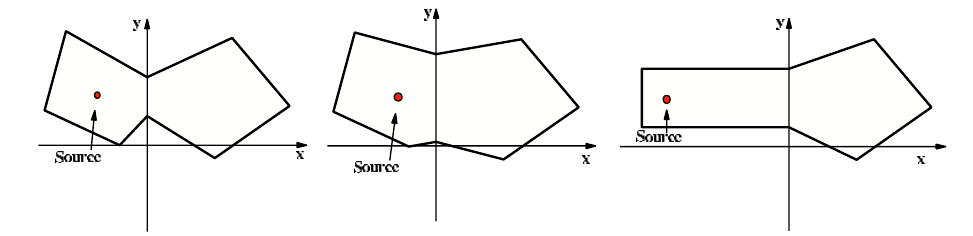
Fig. 4. From the left to the right configurations A, B and C, respectively.